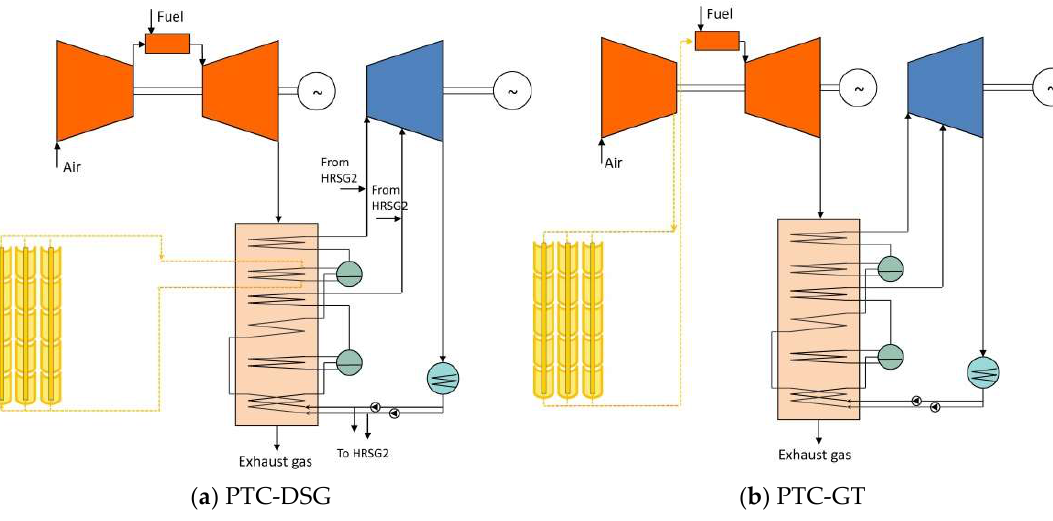
Figure 1. Layout of the configuration based on PTC.